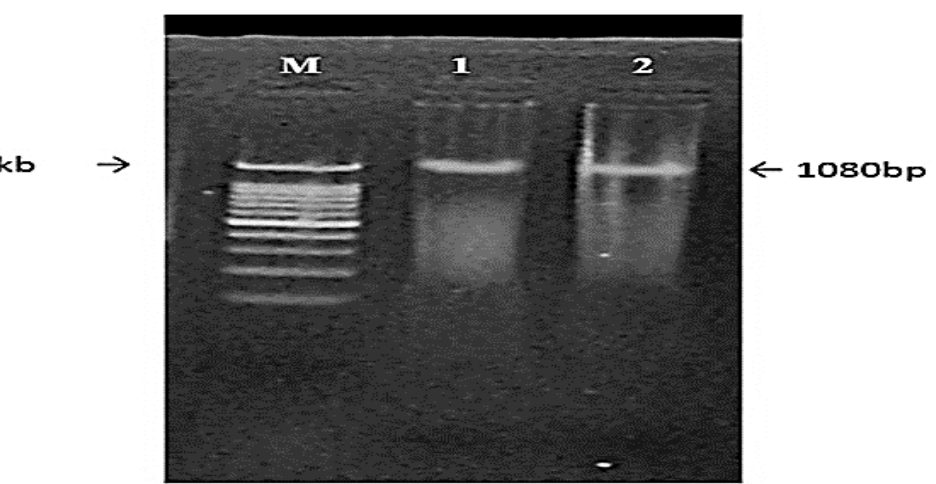
Figure 12. Agarose gel electrophoresis of PCR amplification of xyn2 gene (1080 bp). M, 3 kb DNA marker; Lane 1, xyn2 gene; Lane 1, 2.